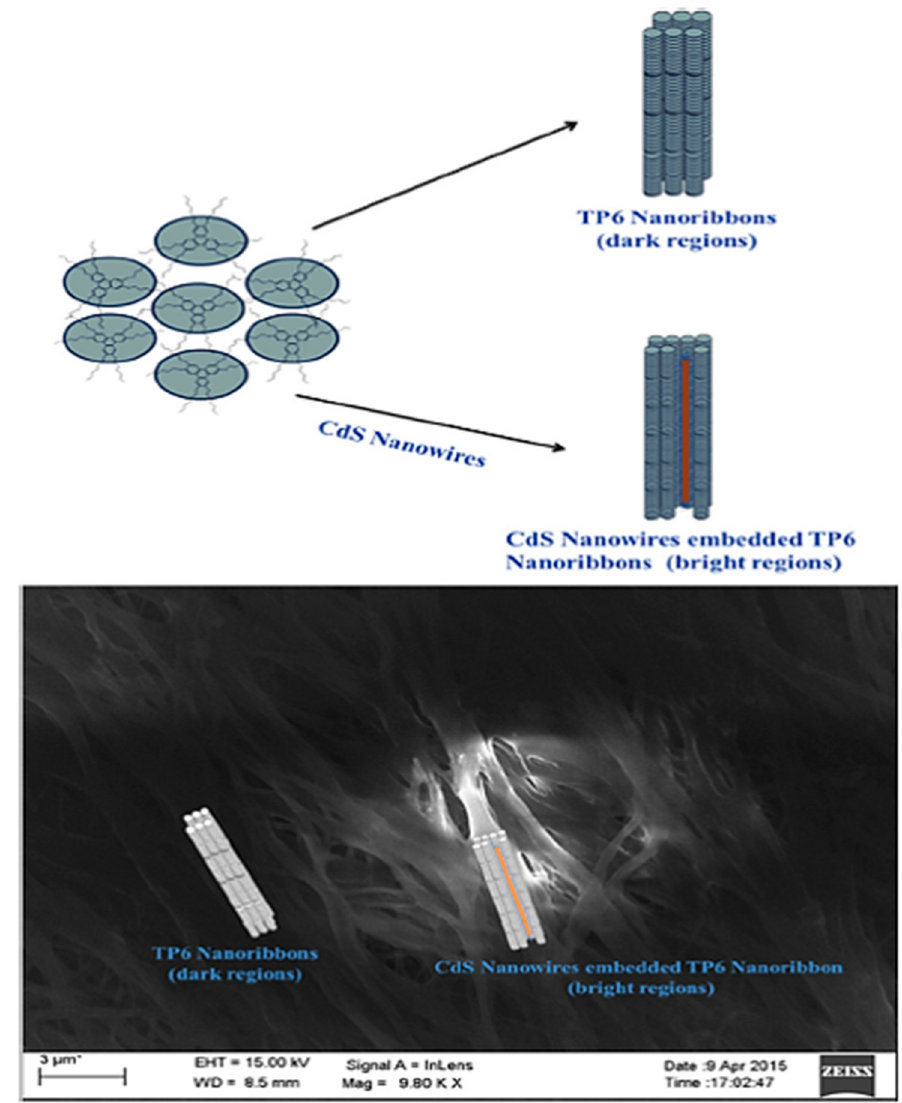
Figure 6. Schematic illustration of trapping of CdS nanowires in nanoribbons of triphenylene and respective FE-SEM images of 0.5 wt% CdS/TP6. Reproduced with permission [71].